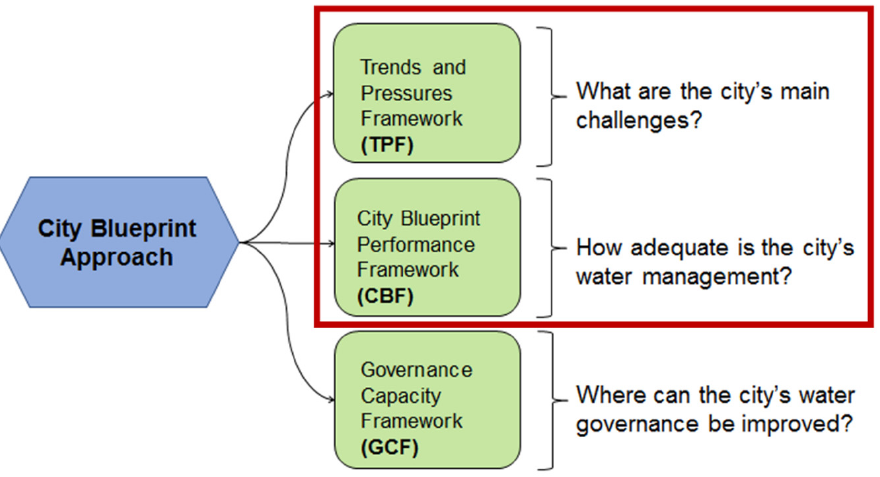
Figure 2. Overview of the City Blueprint Approach with three complementary assessment frameworks. TPF and CBF, which are used in this paper, are in the red box.